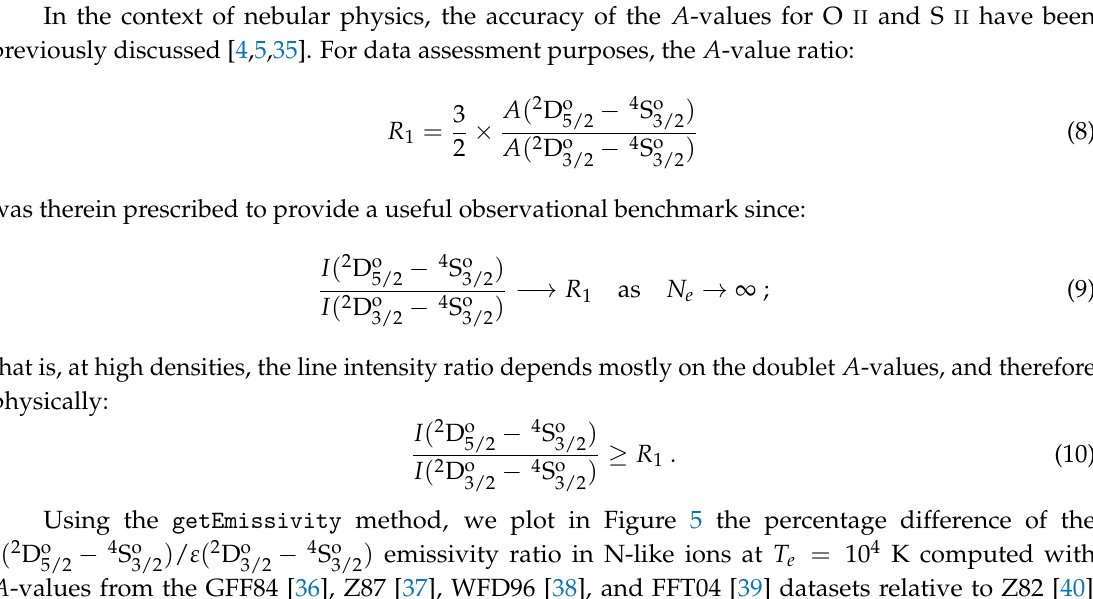
Figure 4. O II Grotrian diagram obtained with the plotGrotrian method of the Atom